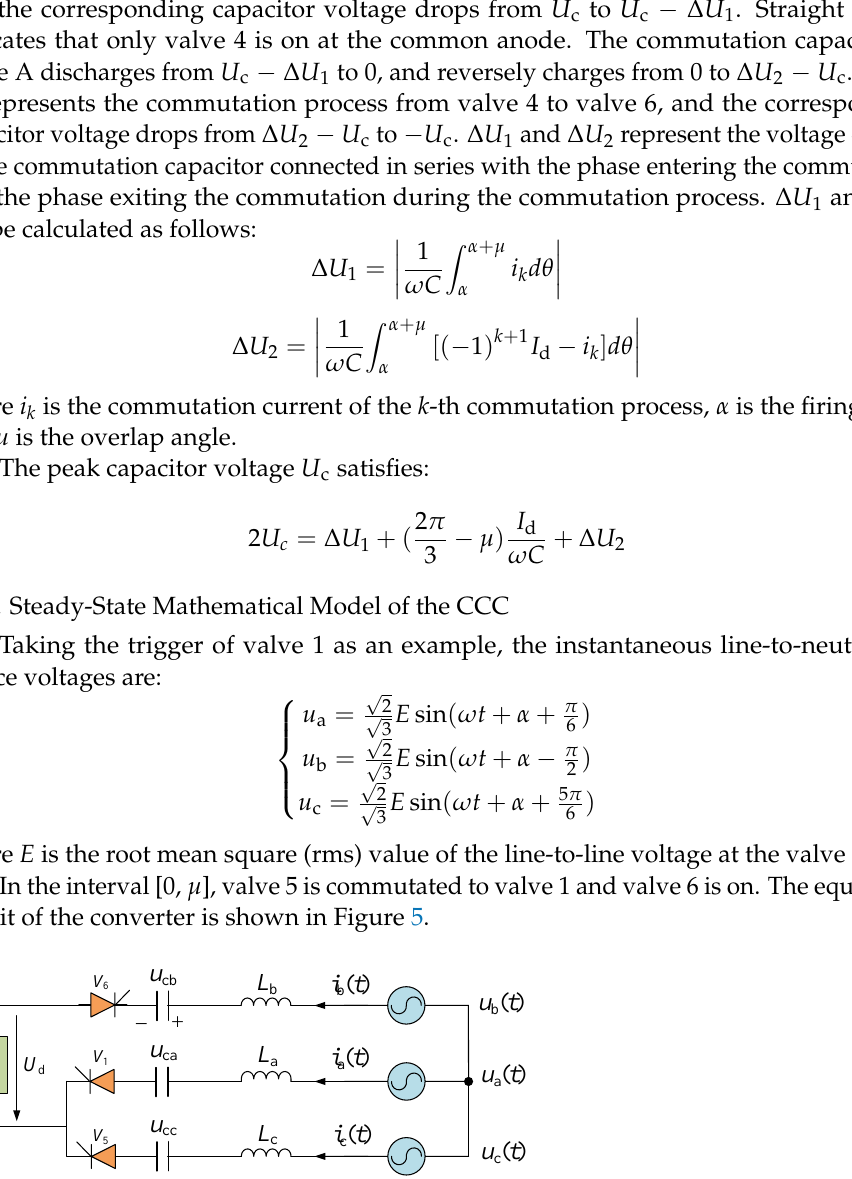
Figure 5. Equivalent circuit of the commutation process in the interval [0, μ ].